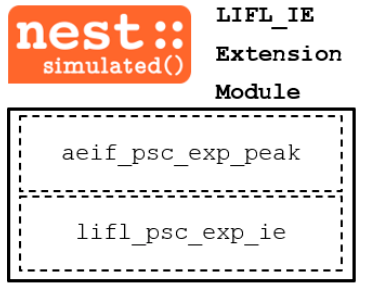
Figure A1. Scheme of the LIFL_IE extension module, containing the lifl_psc_exp_ie and aeif_psc_exp_peak neuron